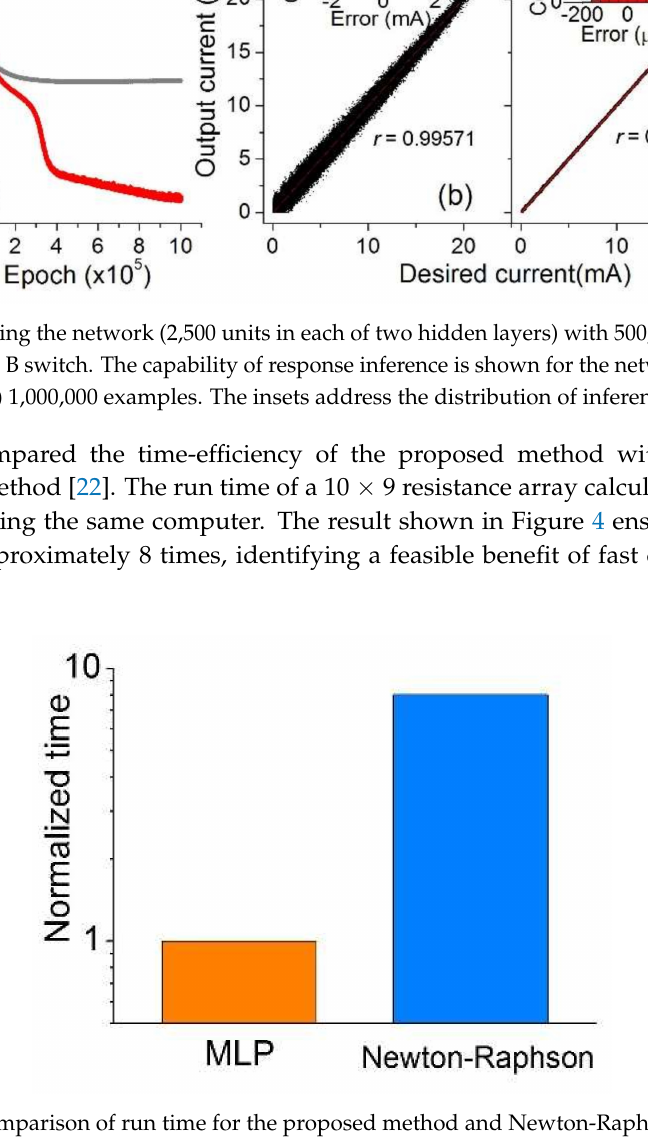
Figure 4. Comparison of run time for the proposed method and Newton-Raphson